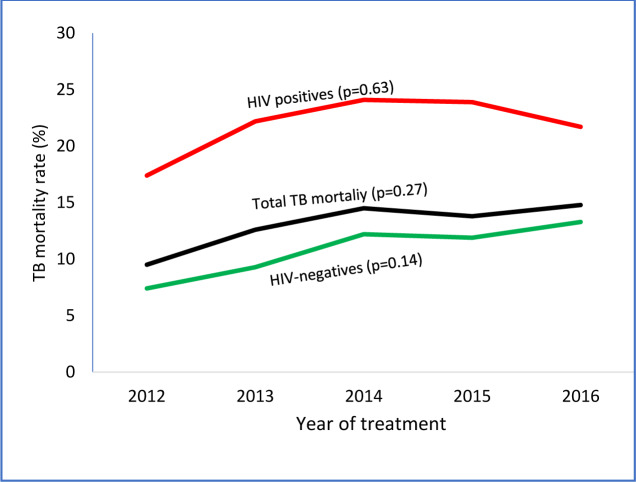
Trends of TB case fatality rate stratify by HIV status in 10 districts of Volta region, Ghana, 2012–2016.The mortality rates of HIV-positive TB are shown in red, rates of HIV-negative TB are shown in green and rates of all forms of TB are shown in black.